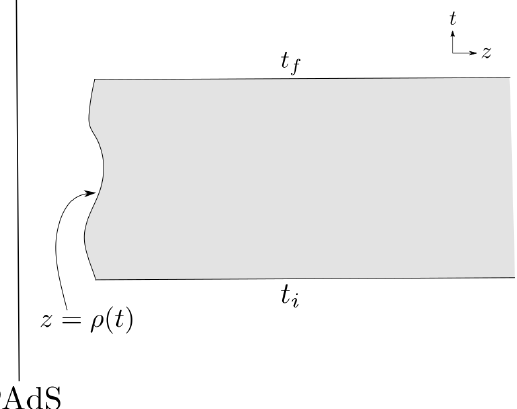
Figure 9: A subregion of Lorentzian Poincaré AdS between two constant time slices with a time dependent boundary. The path integral of the T T -deformed theory on the z = ρ ( t ) boundary defines a path through the space of unitaries, and the gravitational action of the shaded region, including boundary and corner terms, is the natural Lorentzian extension of our previous proposal [ 35 ] for the length or cost of that